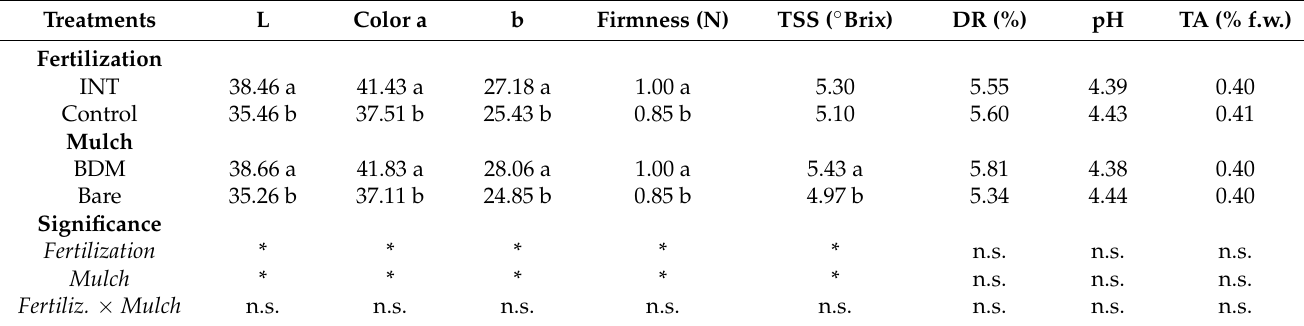
Table 8. Peel color, firmness, total soluble solids, dry residue, pH, and titratable acidity of tomato cv Kendras, in 2018, as influenced by the effects of fertilization and